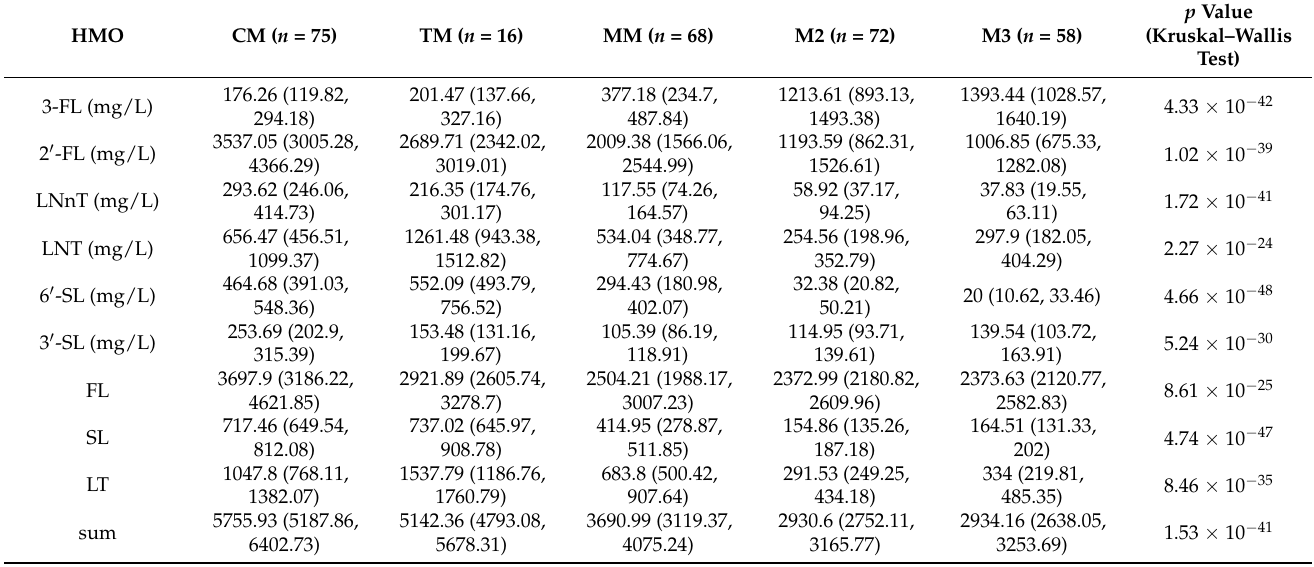
Table 3. The HMOs between different stages in secretors ( n =